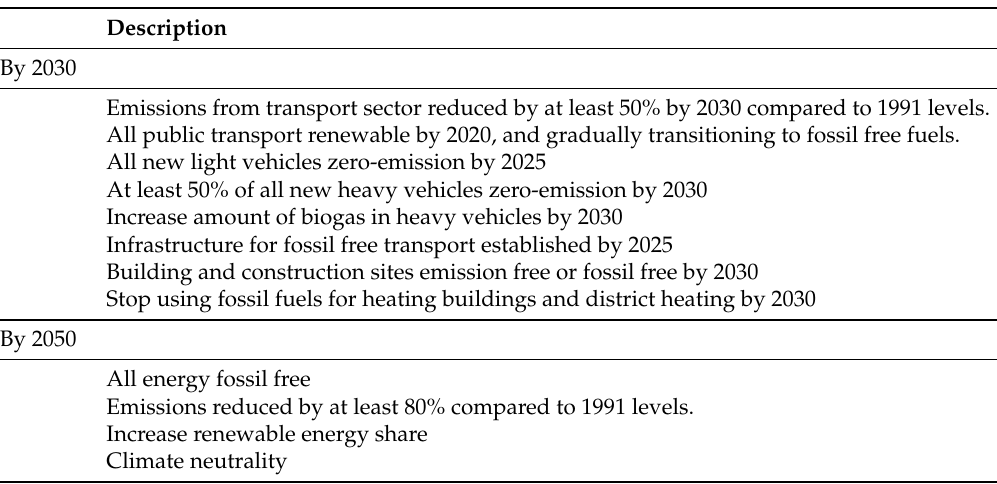
Figure 3. Distribution of CO 2 emissions by sector in Viken and Norway 2018 [10,37,39]. Table 1. Regional climate and energy goals for 2030 and 2050